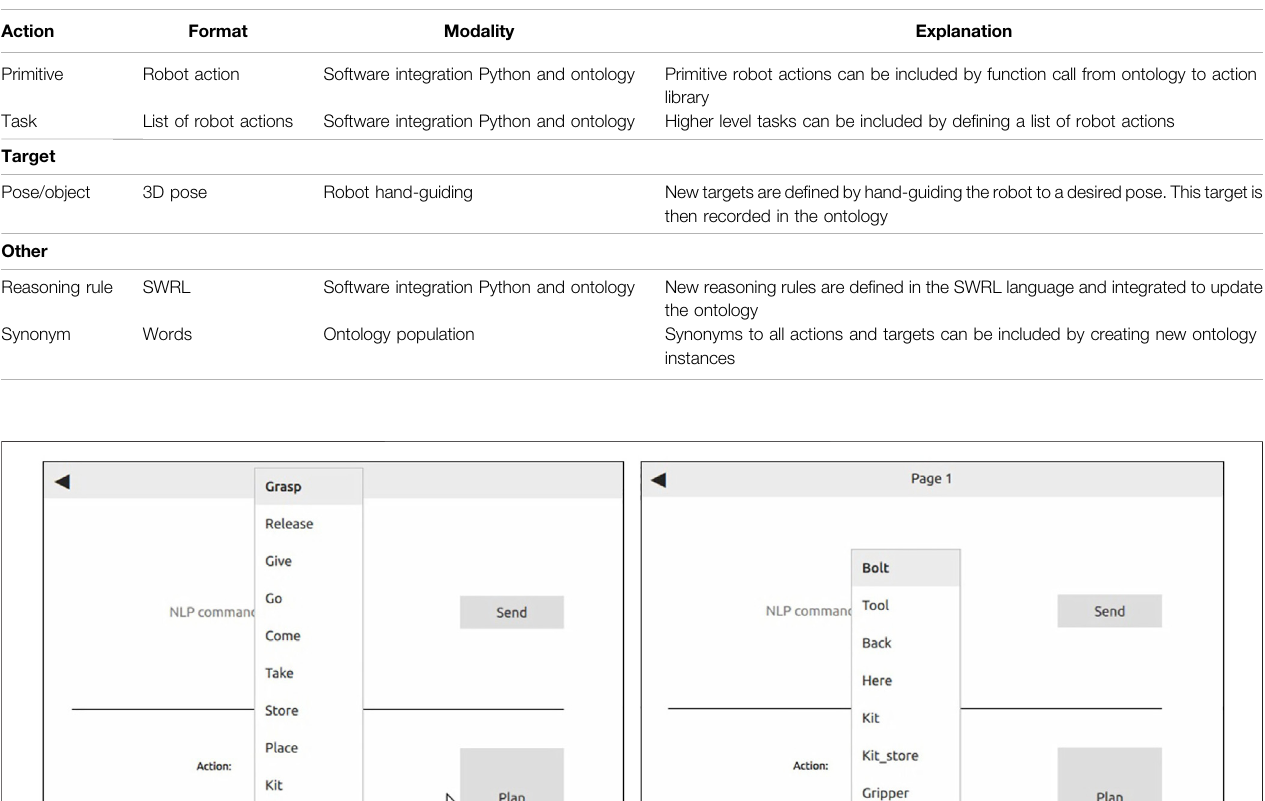
TABLE 2 | Procedure for integrating new knowledge into the system.